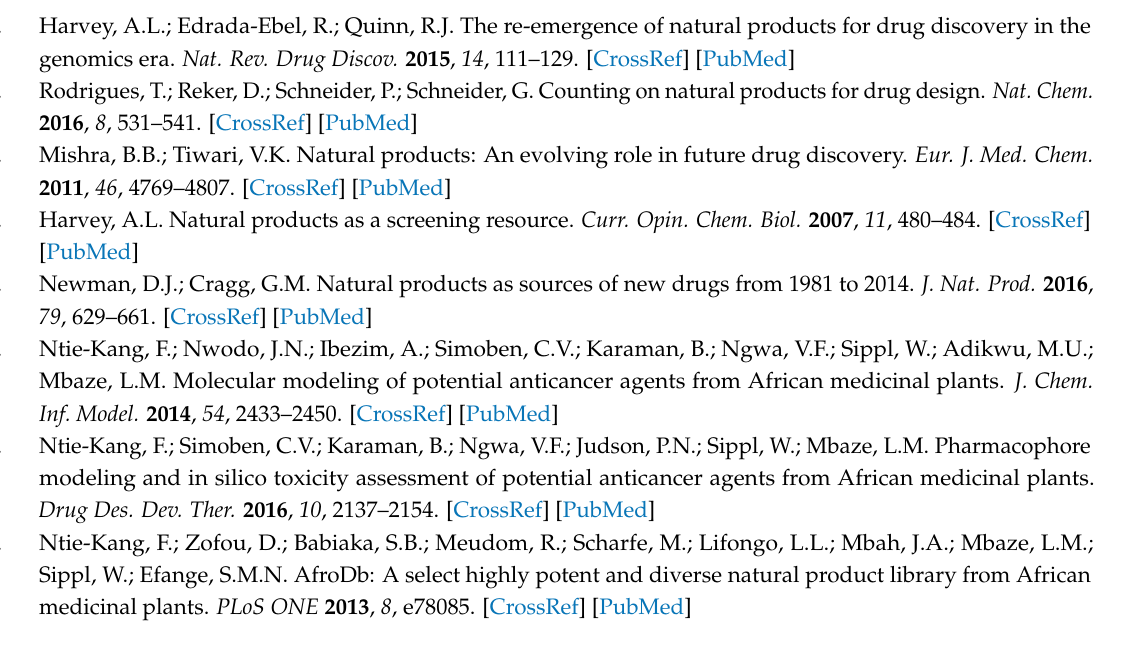
Supplementary Materials: The following are available online. Figure S1: 13 selected compounds on the hit list: black (>1 mg), red (tested negative) greed (active); Figure S2: Complete workflow of the in silico and in vitro screening processes; Figure S3: Predicted common binding mode of active compounds in the peptide binding pockets of Sirt2 (PDB ID: 4R8M): compound 8 in yellow, compound 9 in cyan, hydrogen bonds drawn as dashed lines; Figure S4: Predicted common binding mode of active compounds in the extended C pocket of Sirt2 (left: PDB ID: 5D7P) and the pocket surface is colored according to hydrophobic (green) and hydrophilic (pink) regions Sirt2 (right). Compound 8 in yellow, compound 9 in cyan, hydrogen bonds drawn as dashed lines; Figure S5: Predicted common binding mode of active compounds in the peptide binding pocket of sirt1 (PDB ID: 4ZZJ), with compound 8 shown in yellow, compound 9 in cyan, hydrogen bonds are drawn as dashed lines and EX-243 in green; Protein Preparation Protocols and detailed in vitro assay